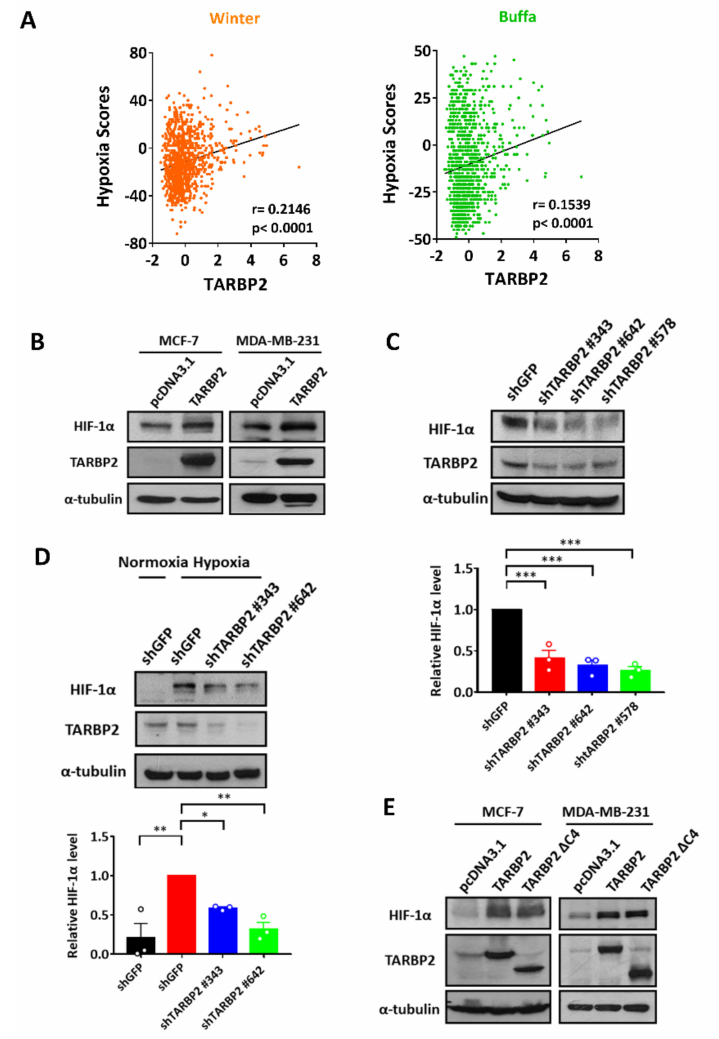
Figure 1. TARBP2 upregulates HIF-1 α expression in normoxic and hypoxic conditions. ( A ) Correla- tion between TARBP2 and hypoxia score using a patient cohort with breast cancer from the TGCA database. Correlation analysis was performed using Pearson’s correlation coefficient. ( B ) TARBP2 induces the expression of HIF-1 α . MCF-7 ( left ) and MDA-MB-231 cells ( right ) were transfected with either control or TARBP2 plasmids for 48 h and cells were harvested to determine the expression of TARBP2 and HIF-1 α using western blot analysis. ( C ) HIF-1 α expression in TARBP2 knockdown MCF-7 cells. MCF-7 cells were applied to indicated shRNAs targeting TARBP2 for 48 h. After selection using puromycin, the efficiency of TARBP2 knockdown and HIF-1 α expression was exam- ined using a western blot. The results of the western blot analyses were quantified and presented in the bottom panel. ( D ) Effect of TARBP2 expression on hypoxia-induced HIF-1 α . MCF-7 cells were incubated under hypoxic conditions for 6 h, and the expression of TARBP2 and HIF-1 α was determined with a western blot analysis. ( E ) Effect of C4-truncated TARBP2 on HIF-1 α expression. MCF-7 ( left ) and MDA-MB-231 cells ( right ) were transfected with the indicated plasmids for 48 h and cells were harvested to determine the expression of TARBP2 and HIF-1 α with a western blot. * p < 0.05, ** p < 0.01, *** p <